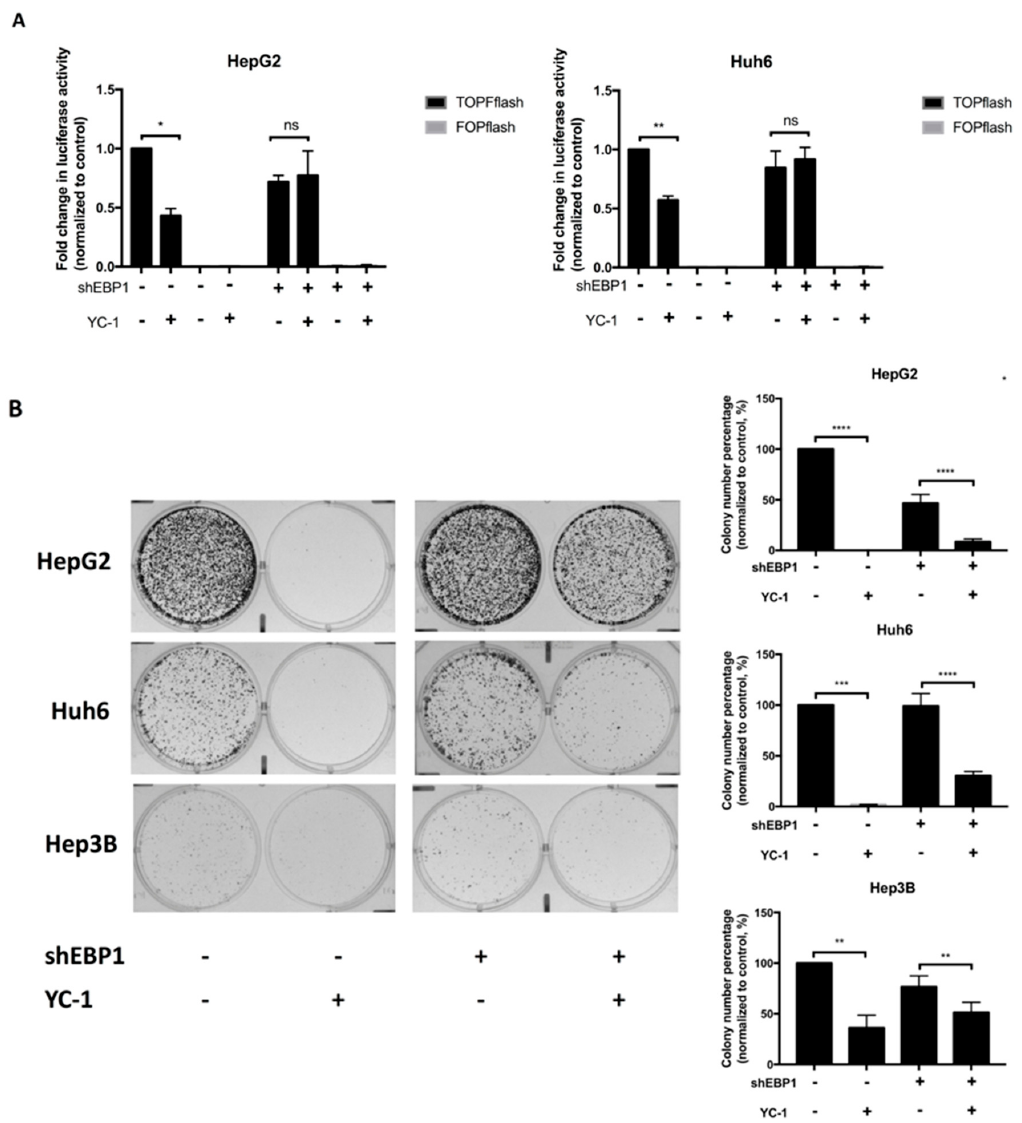
Figure 3. Knockdown of EBP1 inhibited the suppressive effect of YC-1 on HCC cells. HCC cells were transfected with scrambled and EBP1-specific shRNA #2 for 24 hours and recovered for 48 hours. Scrambled shRNA-transfected and EBP1-silenced cells were treated with the IC 50 of YC-1 for 6 hours. Luciferase activity was measured by STF reporter assays ( A ). The indicated cells were seeded in 6-well plates at 5 × 10 4 cells per well and incubated for 48 hours. After the HCC cells were treated with the IC 50 of YC-1 for 24 hours, the medium was replaced. The colonies formed from the indicated cells were observed and counted ( B ). * p < 0.05, ** p < 0.01, *** p < 0.001, **** p < 0.0001, ns: p > 0.05.